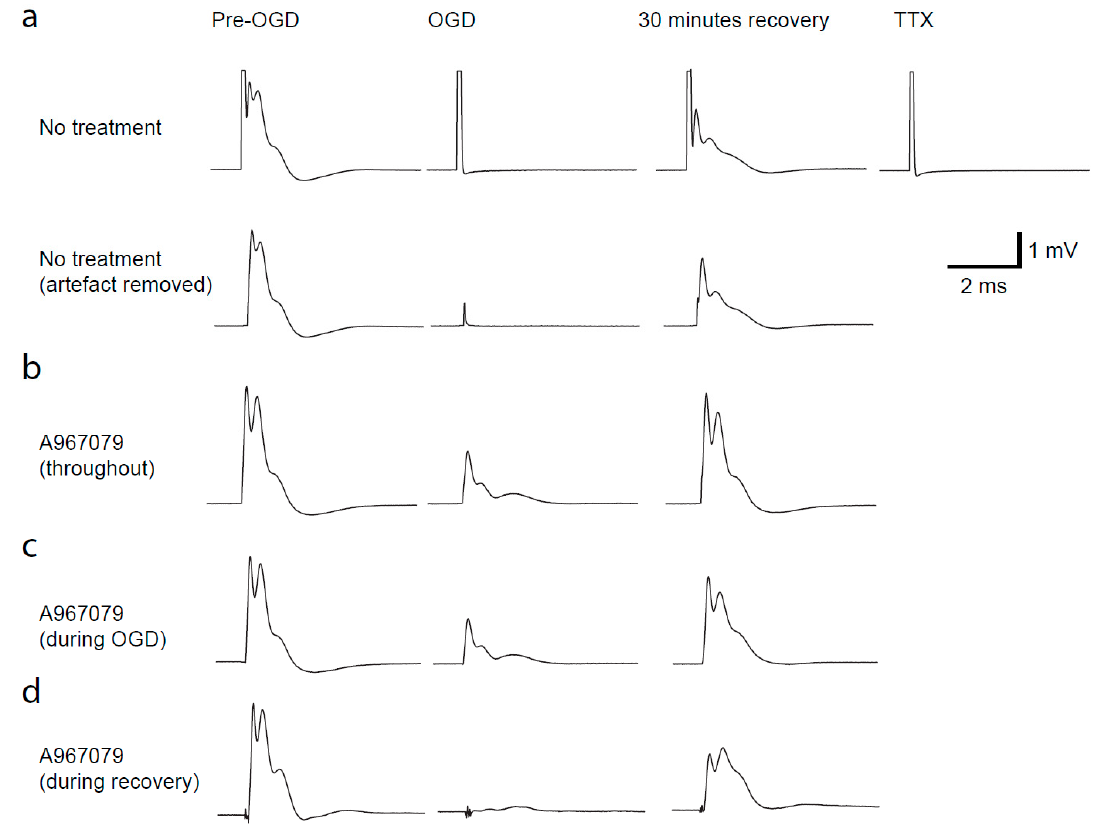
Figure 3. Ischaemia-evoked changes in optic nerve compound action potential (CAP). ( a ) Top row, traces from the left are: CAP in control solution, after 30 min ischemia, after 30 min recovery to control solution, after application of 500 nM TTX to record the stimulus artefact. Row b shows the same traces after the stimulus artefact has been removed from the traces. ( b – d ) Artefact subtracted responses with A-967079 (20 µ M) preincubated and added throughout the experiment ( b ) during ischaemia only ( c ) or during the recovery only ( d ).